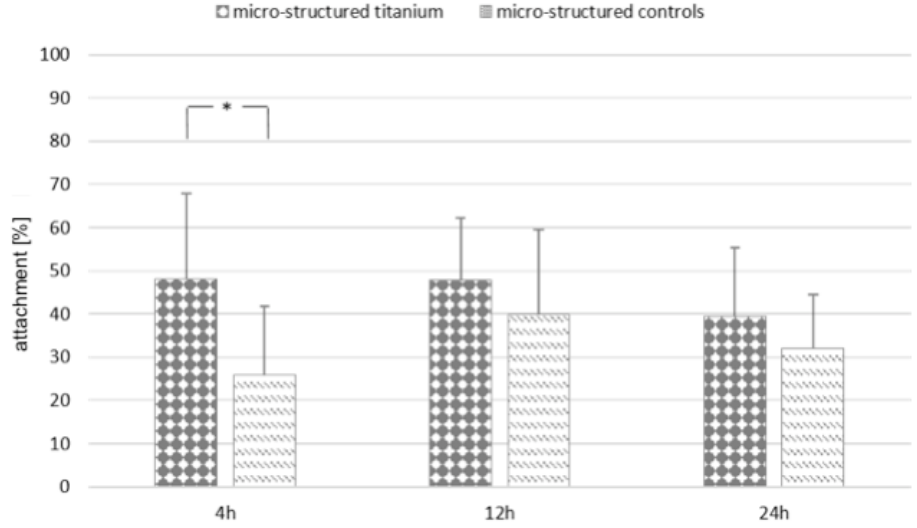
Figure 4. Comparison of relative proportion of focal adhesion (Vinculin) after 4, 12 and 24 h of fibroblast cultivation on microstructured titanium probes with controls. The bars correspond to the mean value, and the line on top corresponds to the ± standard deviation. Statistically significant differences ( p < 0.05) are marked with an asterisk.